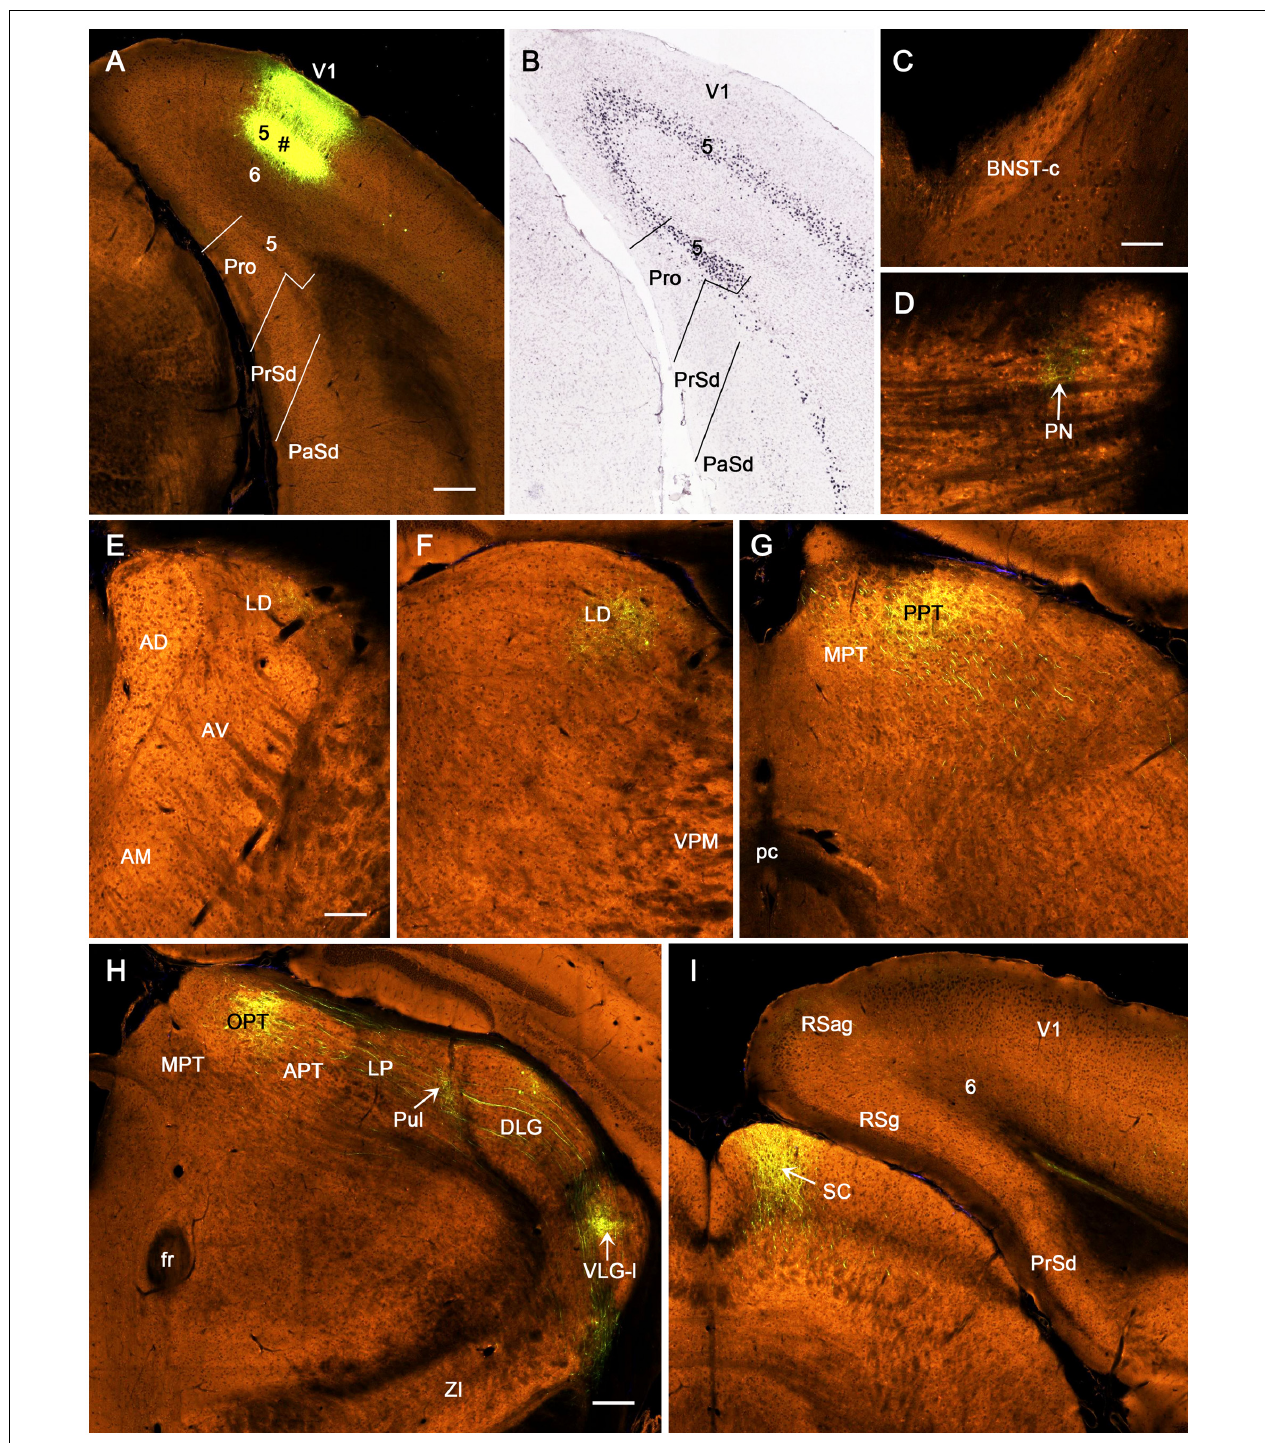
FIGURE 10 | Axon terminal labeling following an anterograde viral tracer injection in V1 of an Etv1 -CreERT2 mouse. All panels are from coronal sections. (A) The injection site (marked by #) is restricted in layer 5 of V1 without involvement in the prostriata. (B) One in situ hybridization (ISH)-stained section showing Etv1 -Cre expression mostly in layer 5 of the prostriata and V1. (C–I) Distribution of labeled axon terminals. The labeled terminals are seen in PN (D) , LD (E,F) , OPT and PPT of the PTN (G,H) , Pul (H) , lateral part of the VLG (VLG-l in H ), and medial part of the SC (I) . Note that (G) is caudal to (H) , which is at the similar level of the (H) in Figure 9 . Note the absence of terminal labeling in the BNST-c (C) , lateral part of zona incerta (H) , and layer 6 of RSg and RSag (I) . Bars: 280 µ m (A) for (A,B) ; 70 µ m (C) for (C,D) ; 140 µ m (E) for (E–G) ; 200 µ m (H) for (H,I) .